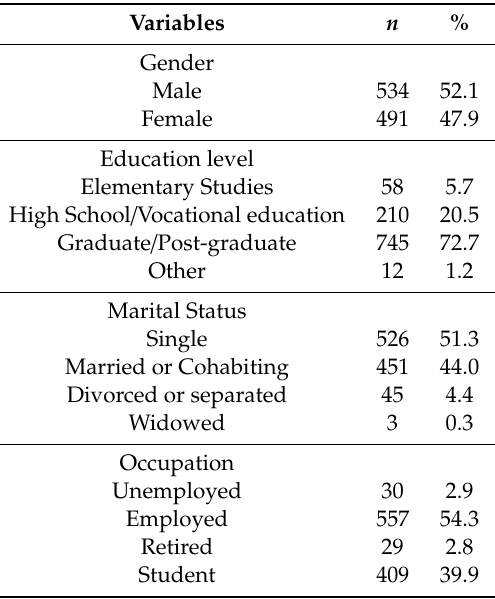
Table 1. Socio-demographic characteristics of the